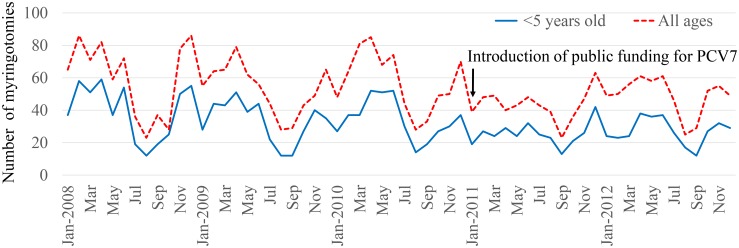
Incidences of myringotomy for all ages (dotted line) and under 5 years old, according to year.Arrow (↓) indicates the introduction of public funding for PCV7. Total number of cases is 3,165 (male, 49%; female, 51%), with 1,916 cases under 5 years old.